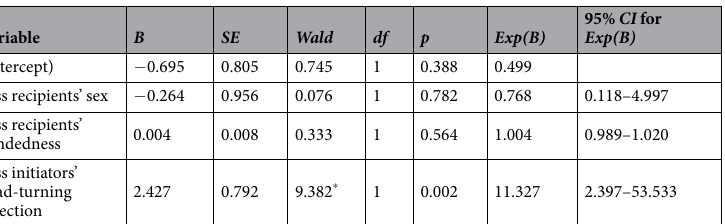
Table 4. Effects of the kiss recipients’ sex, handedness, and the kiss initiators’ head-turning direction on the kiss recipients’ head-turning direction demonstrated through a binary logistic regression on the kiss initiator provided data. Note. N = 48. Coding independent variable, Sex: Male = 1.000; Female = 0.000 (Reference category). Coding independent variable, Kiss initiator’s head-turning direction: Right = 1.000; Left = 0.000 (Reference category). Coding dependent variable, Kiss recipient’s head-turning direction: Left = 0; Right =